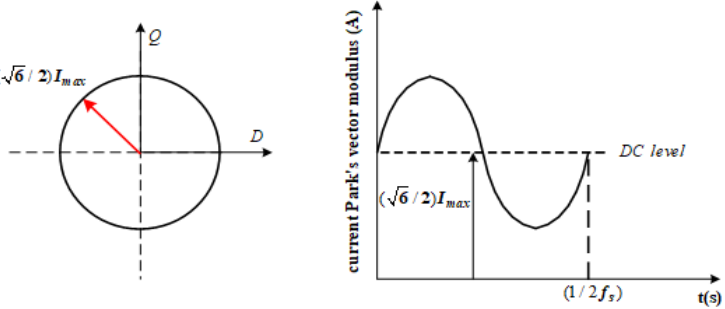
Figure 1. Representation of the motor current Park’s vector and motor current Park’s vector modulus. The BRBs fault will produce additional sideband components at frequencies of (1 − 2 · s ) f s and (1 + 2 · s ) f s in the motor supply current spectrum, where f s and s are the fundamental supply frequency and the rotor slip, respectively. Then, Equation (2) becomes invalid